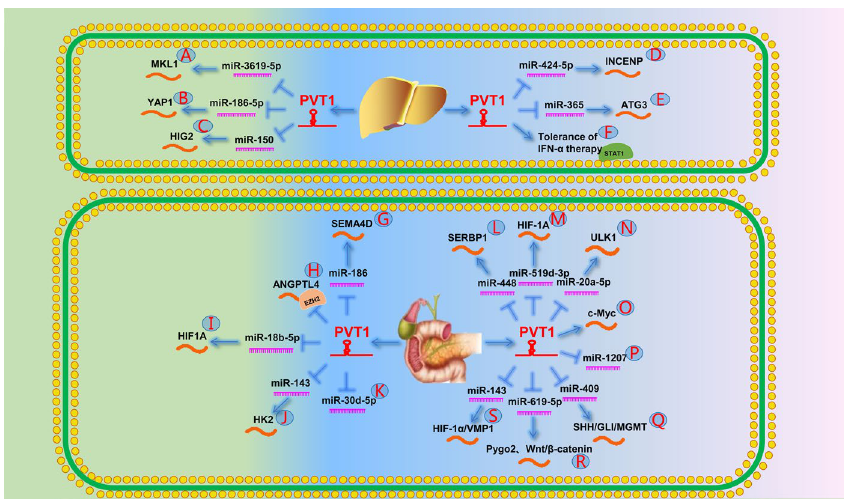
Fig. 3 The role of PVT1 in the digestive system [2]. A PVT1 promotes the expression of MKL1 by targeting miR-3619-5p. B PVT1 promotes the expression of YAP1 by targeting miR-186-5p. C PVT1 promotes the expression of HIG2 by targeting miR-150. D PVT1 promotes the expression of INCENP by targeting miR-424-5p. E PVT1 promotes the expression of ATG3 by targeting miR-365. F PVT1 can decrease the phosphorylation of STAT1 and finally leads to the tolerance of IFN-α therapy. G PVT1 promotes the expression of SEMA4D by targeting miR-186. H PVT1 downregulates its expression by recruiting EZH2 to the ANGPTL4 promoter region. I PVT1 downregulates miR-18b-5p expression by binding to EZH2 and promotes HIF1A expression. J PVT1 promotes the expression of HK2 by targeting miR-143. K PVT1 directly binds to miR-30d-5p. ( L ) PVT1 promotes the expression of SERBP1 by targeting miR-448. M PVT1 promotes the expression of HIF-1A by targeting miR-519d-3p. N PVT1 promotes the expression of ULK1 by targeting miR-20a-5p. O PVT1 enhances gemcitabine resistance of PDAC by increasing c-Myc expression. P PVT1 enhances gemcitabine resistance of PC by inhibiting miR-1207 expression. Q PVT1 promotes the SHH/ GLI/MGMT signal pathway by targeting miR-409. R PVT1 upregulates Pygo2 by targeting miR-619-5p and ultimately activates Wnt/β-catenin signaling pathway, resulting in PC resistance to gemcitabine chemotherapy. S PVT1 promotes the HIF-1α/VMP1 signaling pathway by targeting miR-143, resulting in PC resistance to gemcitabine